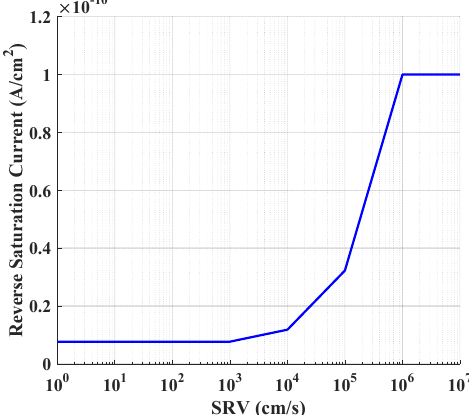
Figure 6. Impact of SRV on the reverse saturation current of the equivalent diode around V oc.